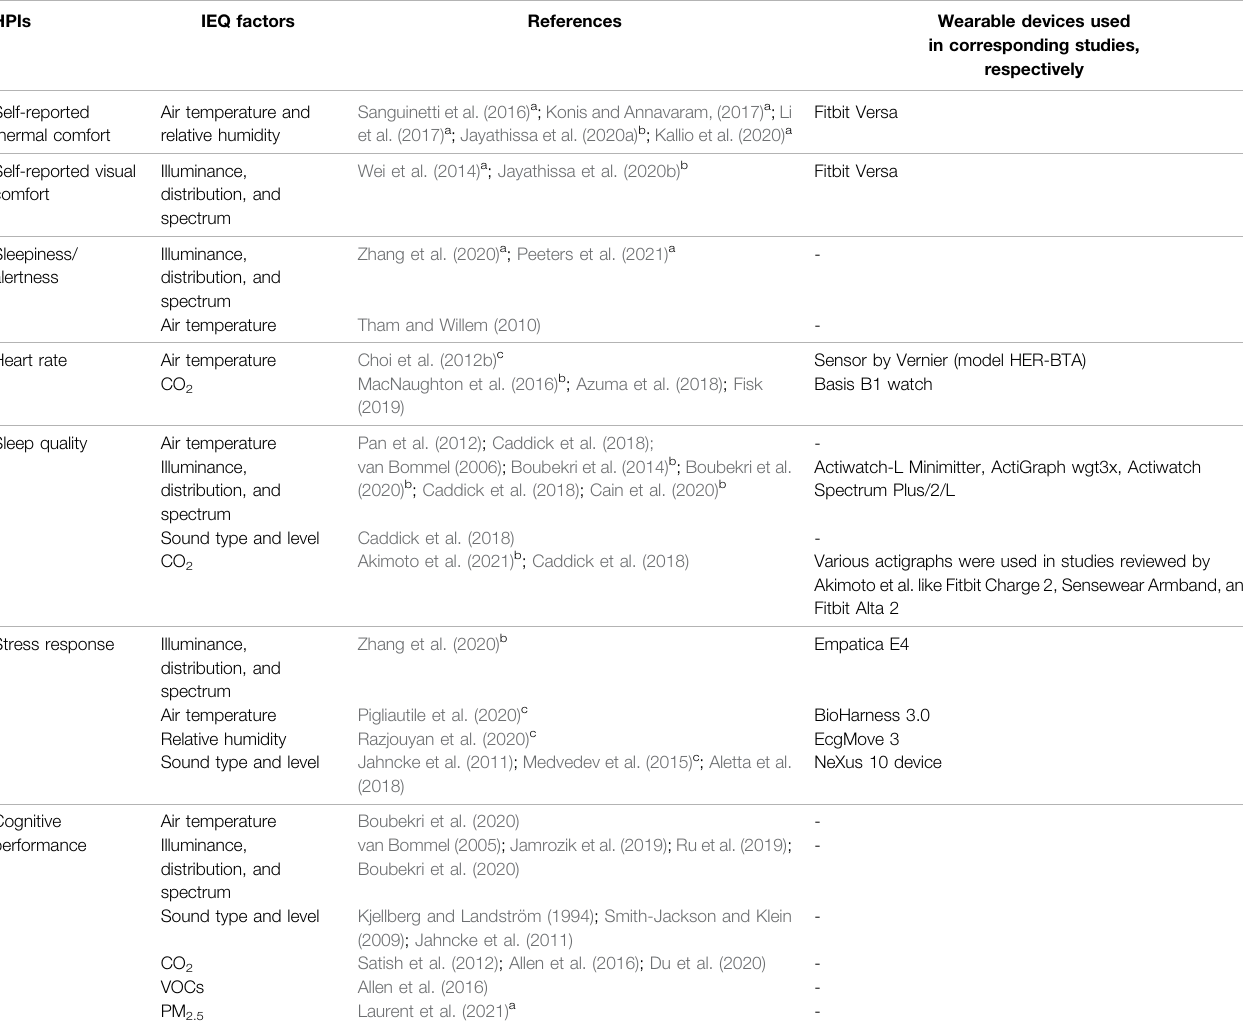
a Denotes studies that used smartphones. b Denotes studies that used a wrist-worn device (e.g., a smartwatch) to collect HPI.